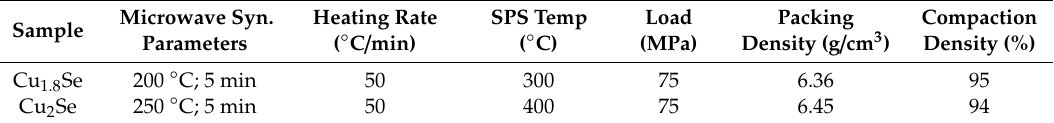
Table 1. Synthesis and spark plasma sintering (SPS) consolidation parameters for the investigated